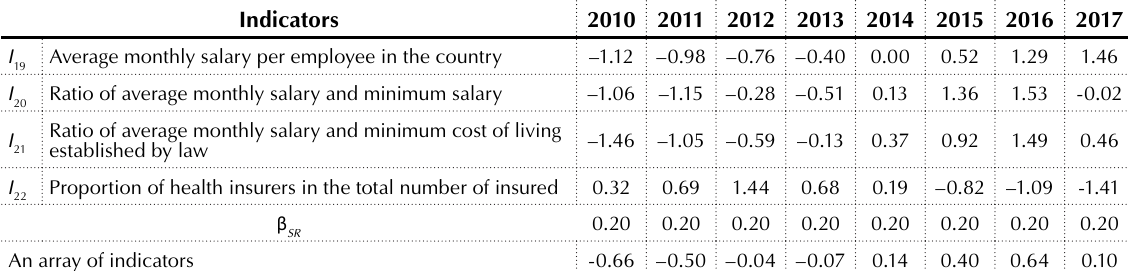
Table 8. Calculation of the socio-economic potential of health insurance/an array of indicators of the management of insurers’ financial resources of socio-economic potential (specified values)